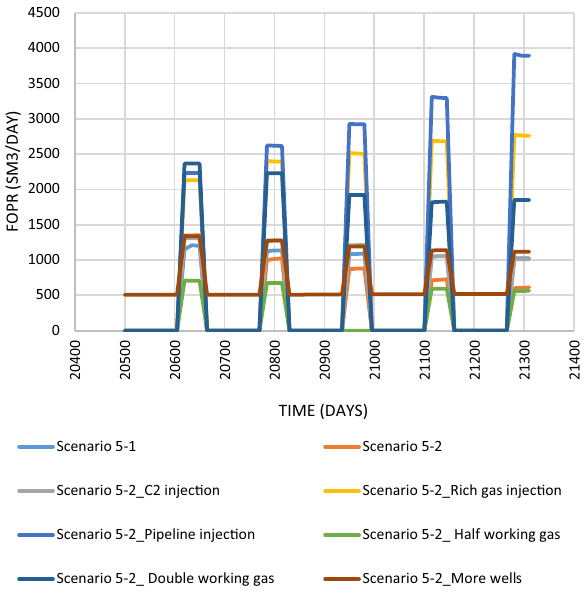
Fig. 10 An increased field condensate production rate under different